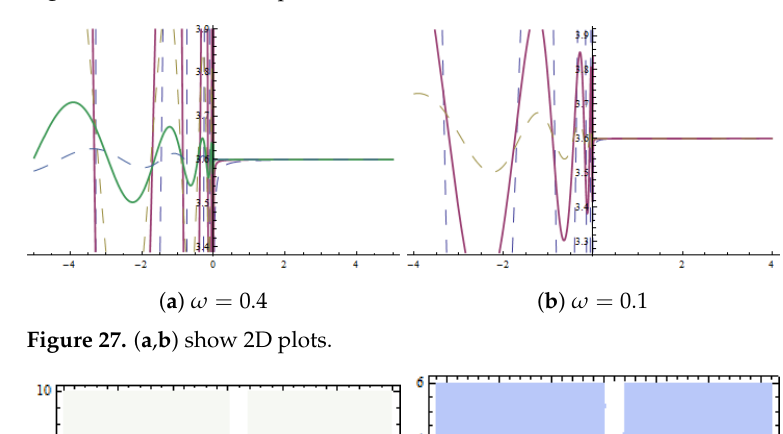
Figure 26. ( a , b ) show 3D plots.